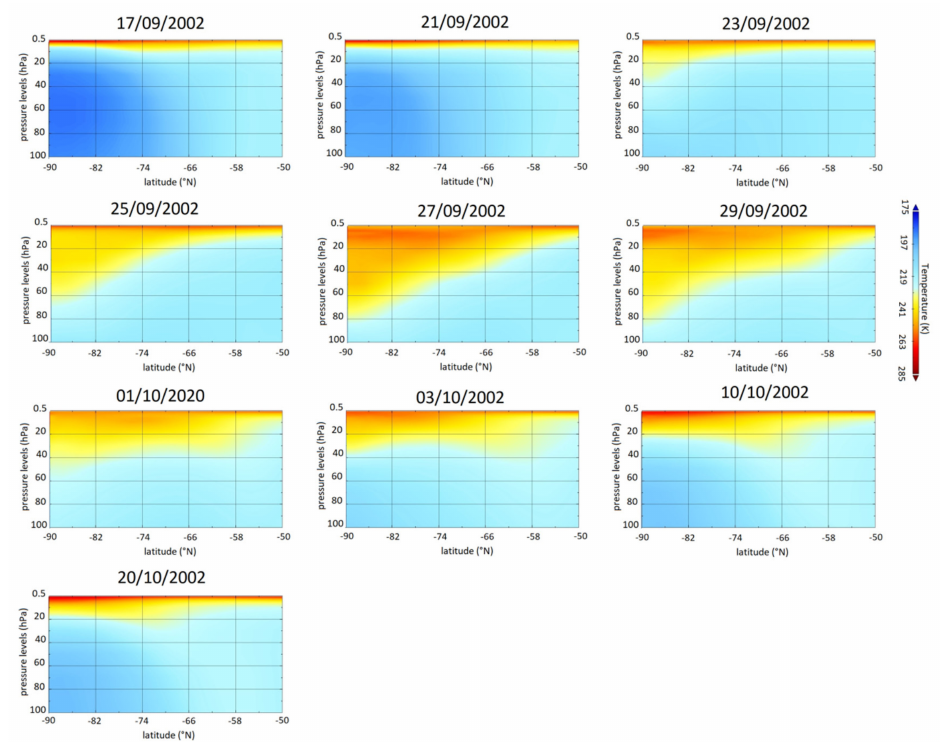
Figure 9. Vertical profile of polar temperature during SSW in 2002 in the SH.